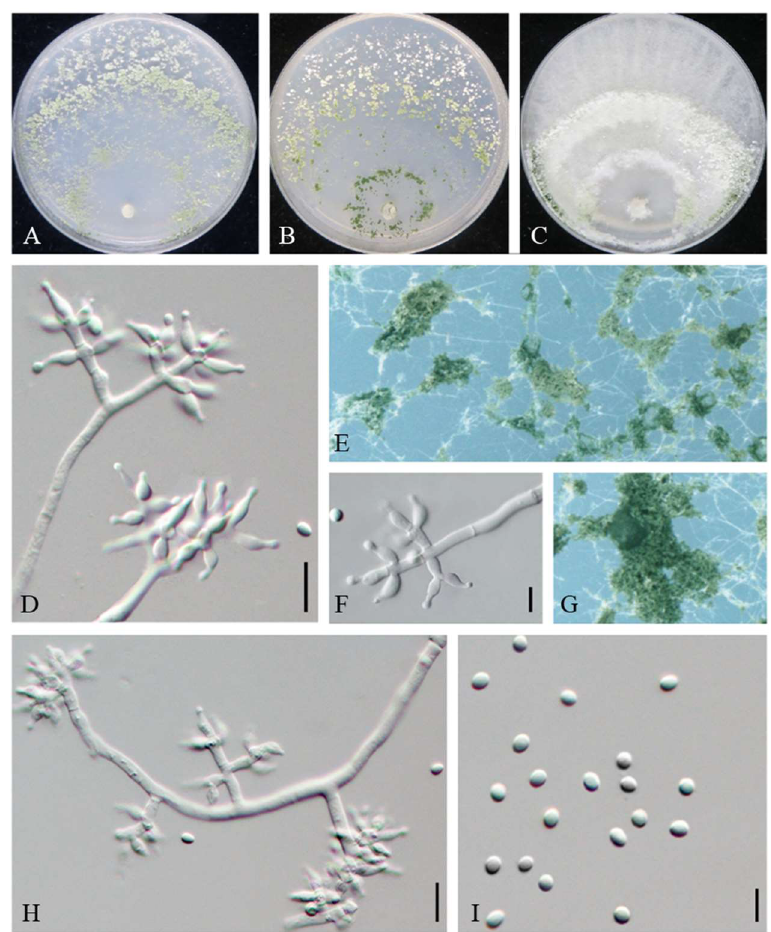
Figure 3. Trichoderma miyunense (JZBQF9). Cultures at 25 °C after 7 days on ( A ) CMD, ( B ) SNA, and ( C ) PDA; ( D , F , H ) conidiophores and phialides; ( E , G ) conidiation pustules on SNA after 7 days; ( I ) chlamydospores. Scale bars: ( D , H ) = 10 µm, ( F , I ) = 5 µm.